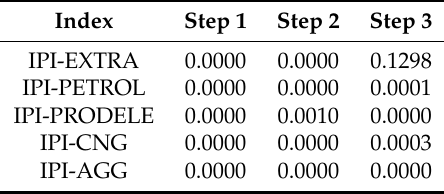
Table 31. Modified Diebold–Mariano statistics for the equality of forecast accuracy of two forecasts under general assumptions with an expanding window from 2008:01 to 2018:12. The null hypothesis is that the two methods have the same forecast accuracy. The loss function is the squared